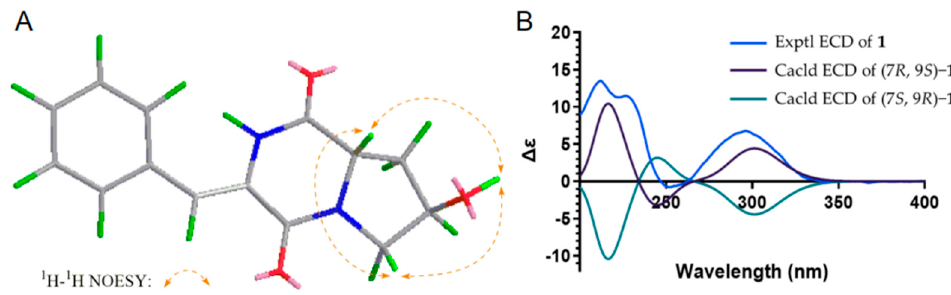
Figure 3. Key NOESY correlations and ECD curves of compound 1.